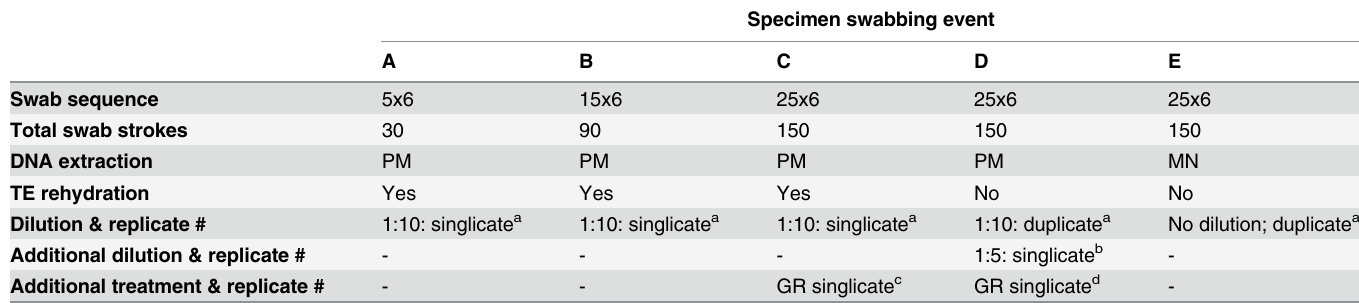
Table 1. Treatments, replicate numbers, and optimizations for each specimen swabbing event, chronological from left to